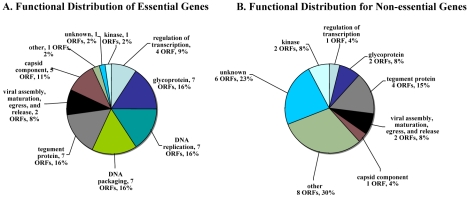
Distribution of functional annotations for essential and non-essential genes.A. Distribution of functional annotations for essential genes. Essential genes are significantly enriched for DNA replication (Bonferroni corrected p-value <10−4) and DNA packing (corrected p-value <10−4) functional categories. B. Distribution of functional annotations for non-essential genes. Non-essential genes are significantly enriched for other (corrected p-value <10−3) and unknown (corrected p-value <0.01) functional categories. Statistical significance was determined by a hypergeometric test.